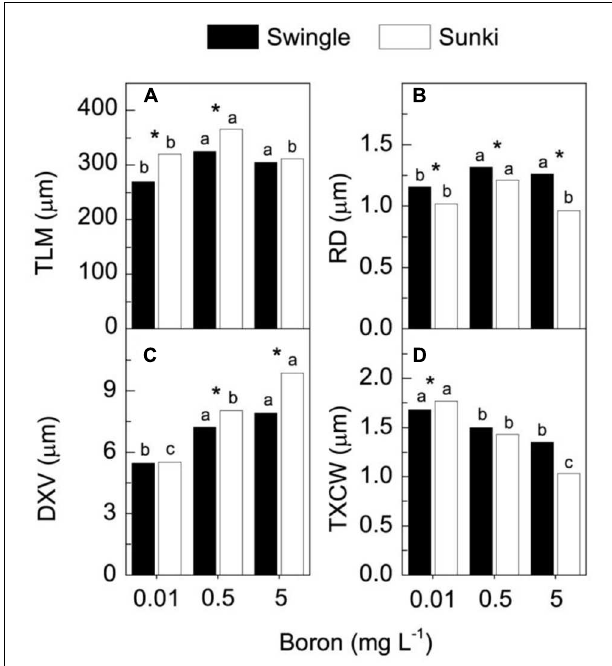
FIGURE 6 | Thickness of leaf mesophyll (TLM) (A), root diameter (RD) (B), diameter of xylem vessels (DXV) (C) and xylem cell wall thickness (TXCW) (D) in sweet orange trees grafted on Swingle or Sunki rootstocks grown in nutrient solution with varying concentrations of boron for 130 days. Asterisks compare rootstocks in a given boron concentration, whereas lowercase letters indicate significant difference between boron concentrations in a given rootstock (Tukey test at p <